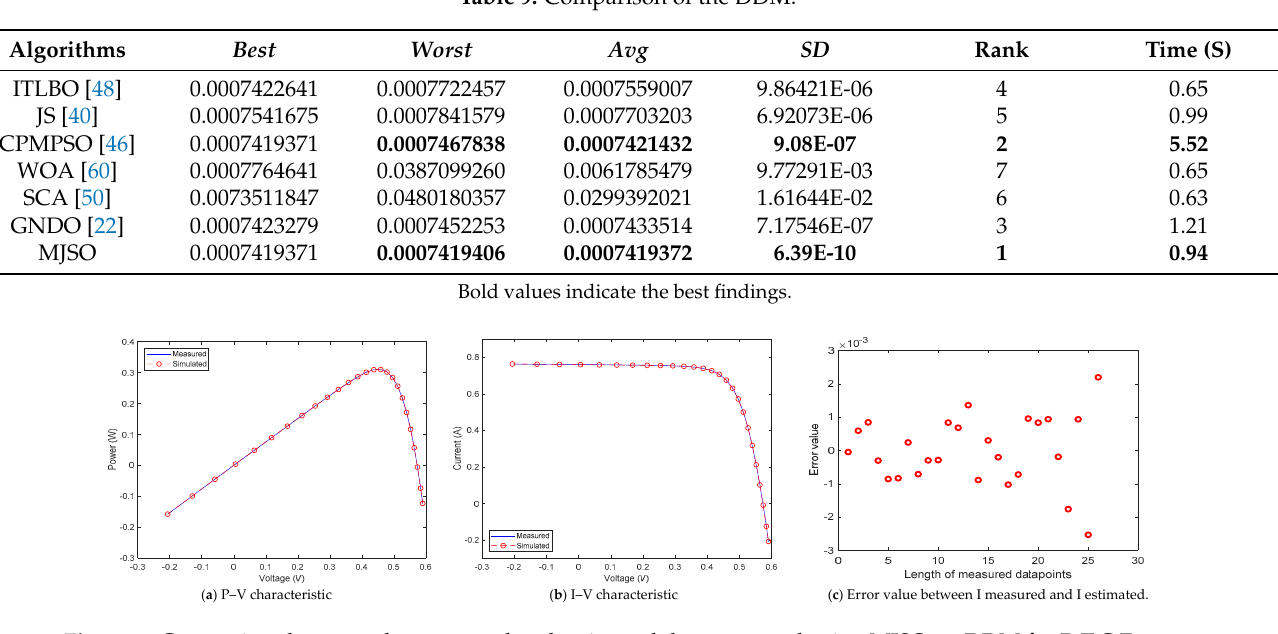
Table 10. Comparison on the Photowatt-PWP201 module under extracted parameter values and the corresponding RMSE.